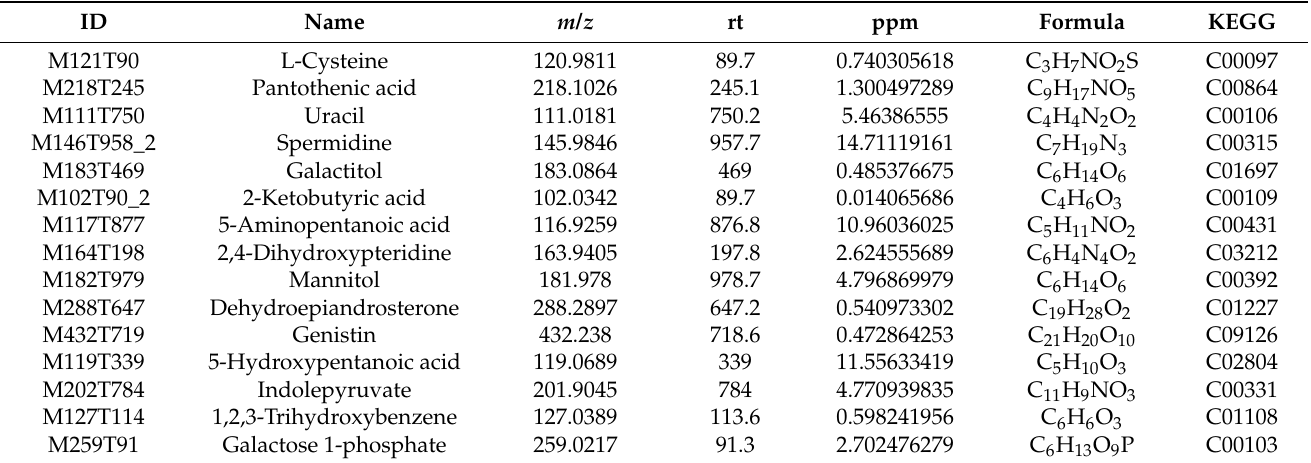
Figure 6. Identification of potential biomarkers of DOX − induced cardiotoxicity and DXXK car- dioprotection. ( A ) Changes of differential metabolites between the control group and DOX group. ( B ) Changes of differential metabolites between the DOX group and DXXK group. ( C ) The cluster heatmap of metabolites in the control group and DOX group. ( D ) The cluster heatmap of metabolites both in the DOX group and DXXK group. ( E ) Correlation analysis of different metabolites between the control group and DOX group. ( F ) Correlation analysis of different metabolites between the DOX group and DXXK group. Table 1. Potential differential metabolites of DOX-induced myocardial cell injury.